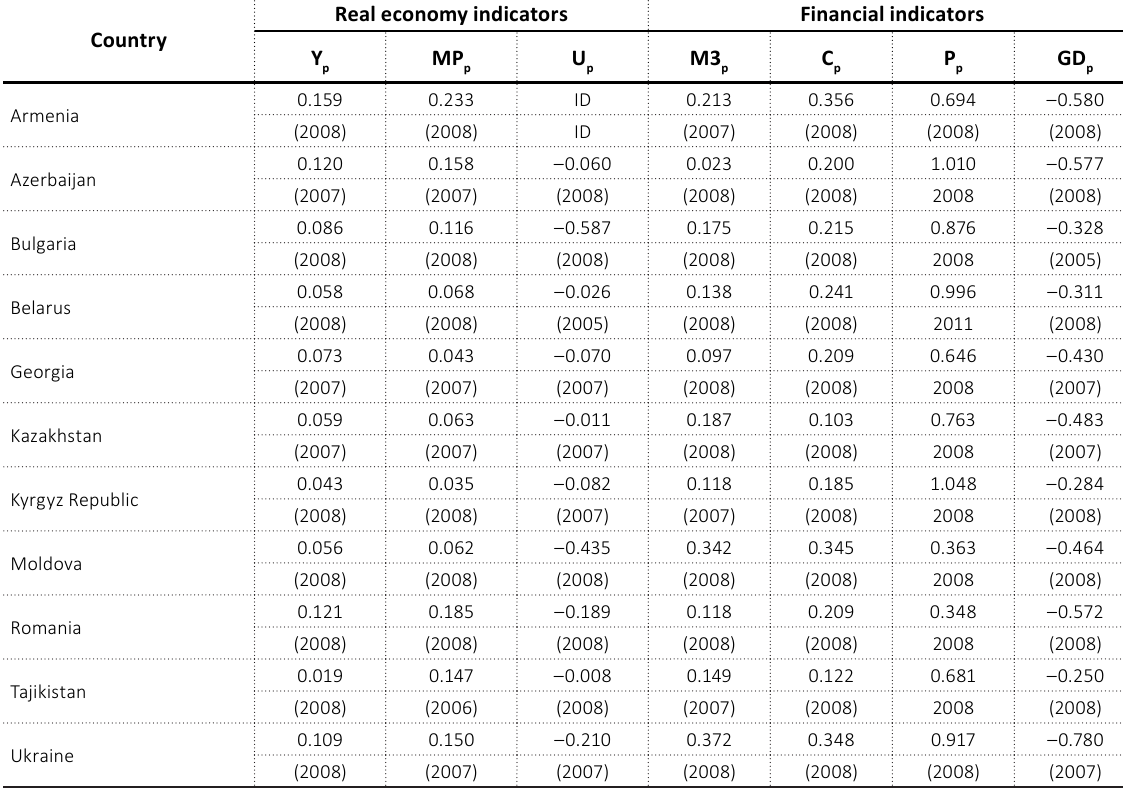
Table 1. Cycle peaks before financial crises of 2008–2010 as natural